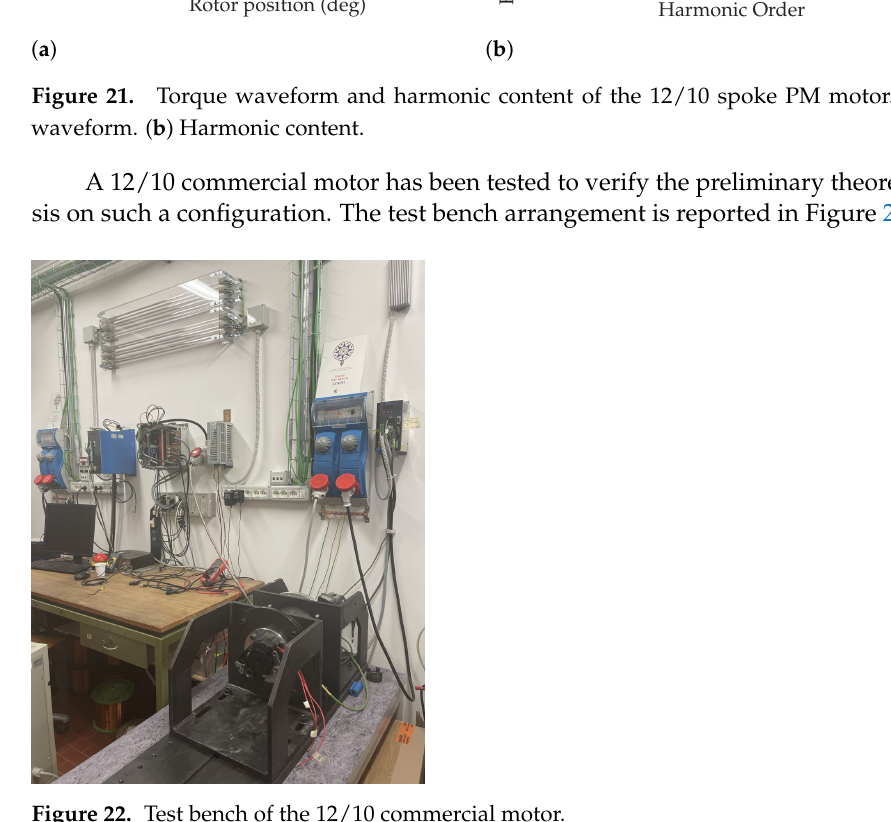
Figure 22. Test bench of the 12/10 commercial